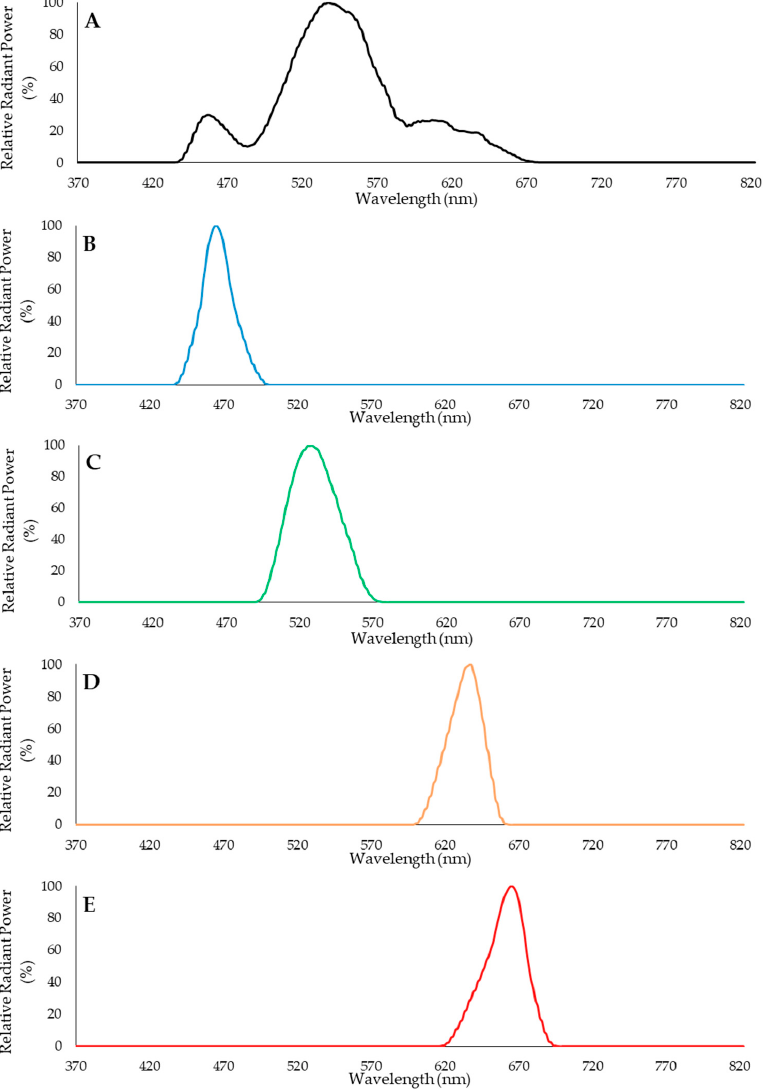
Figure 2. Relative radiant power (%) applied during refrigerated storage: White ( A ), Blue ( B ), Green ( C ), Orange ( D ), and Red ( E ) LEDs.